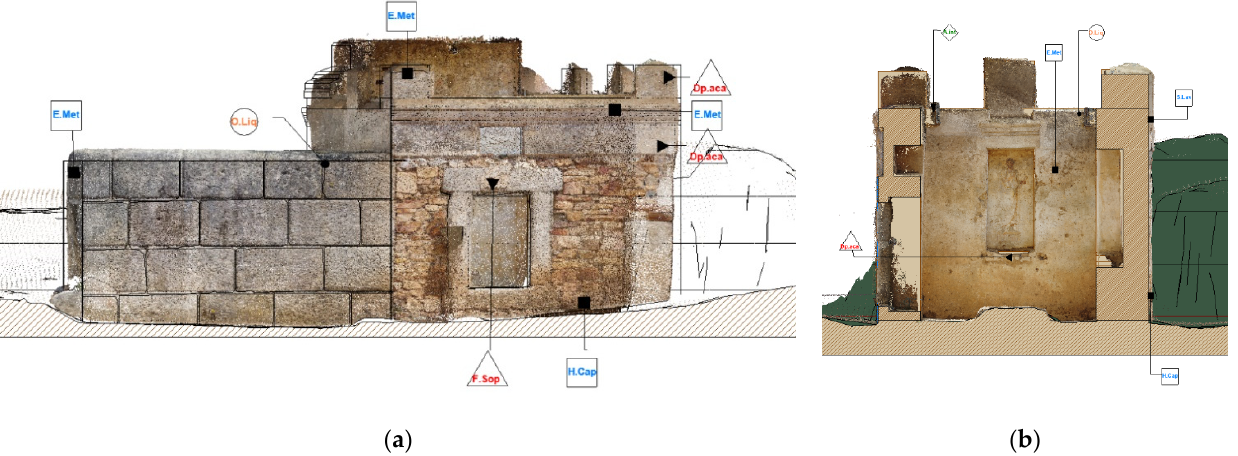
Figure 21. Example of a pathology plan showing the lesions of each of the constructive elements of the buildings. ( a ) Injury map of the Niger and Julios building elevation. ( b ) Map of lesions. Cross section of the Voconios building.